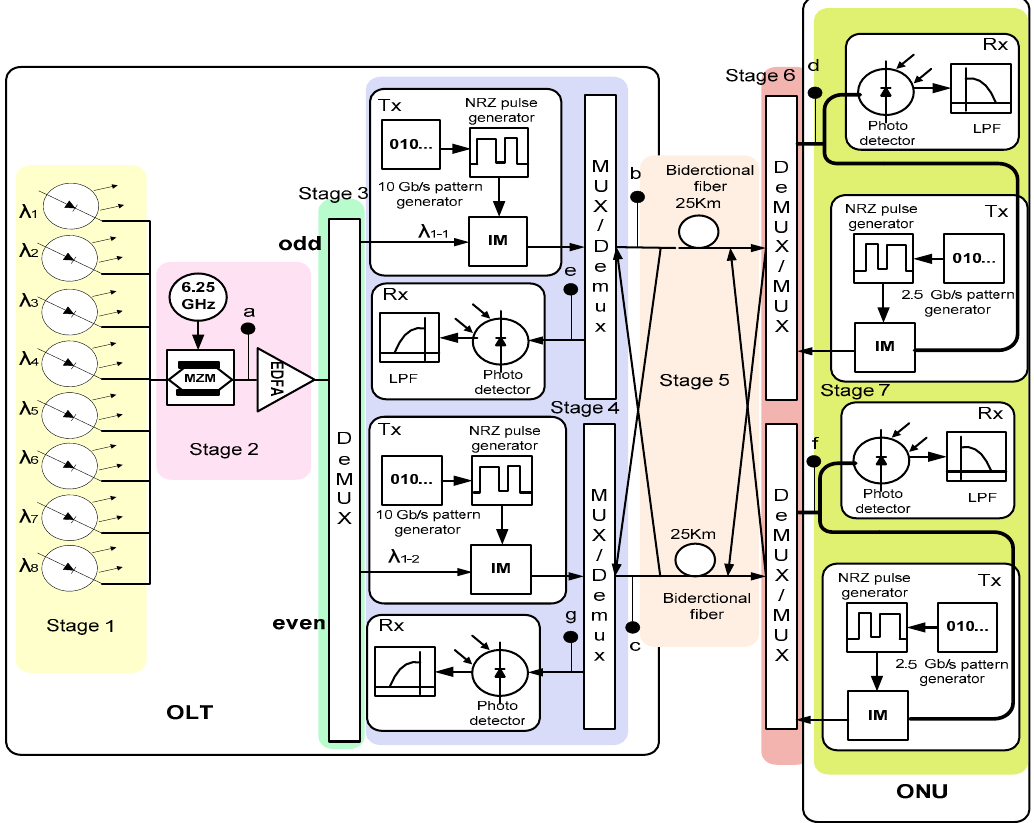
Figure 2. Detailed design for the proposed DWDM-PON system with enhanced cross seeding mechanism. MZM: Mach Zehnder modulator; EDFA: Erbium-Doped Fiber Amplifier; NRZ: Non-Return to Zero; IM: Intensity Modulator; LPF: Low Pass Filter.